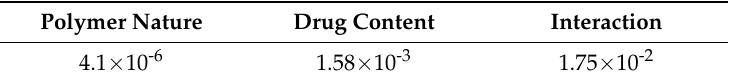
Figure 9. Mucoadhesion residence times for the batches on bovine vaginal mucosa. Table 5. Results of the ANOVA processing of the mucoadhesion times of the batches; the factors are the nature of the polymer and the drug content. p -values below α = 0.05 indicate no significant